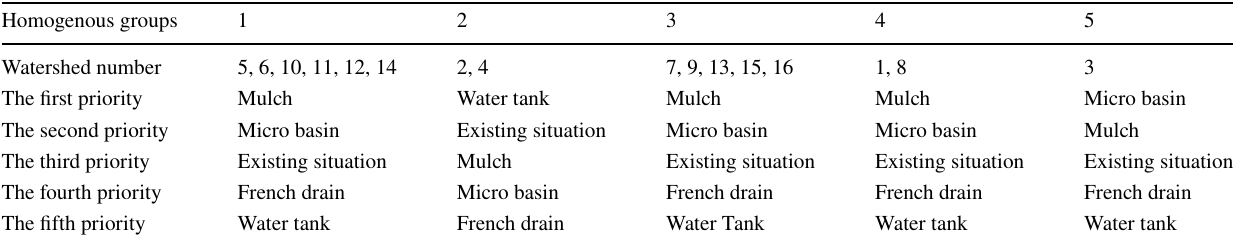
Table 8 The prioritization of RWHSs based on AHP Homogenous groups